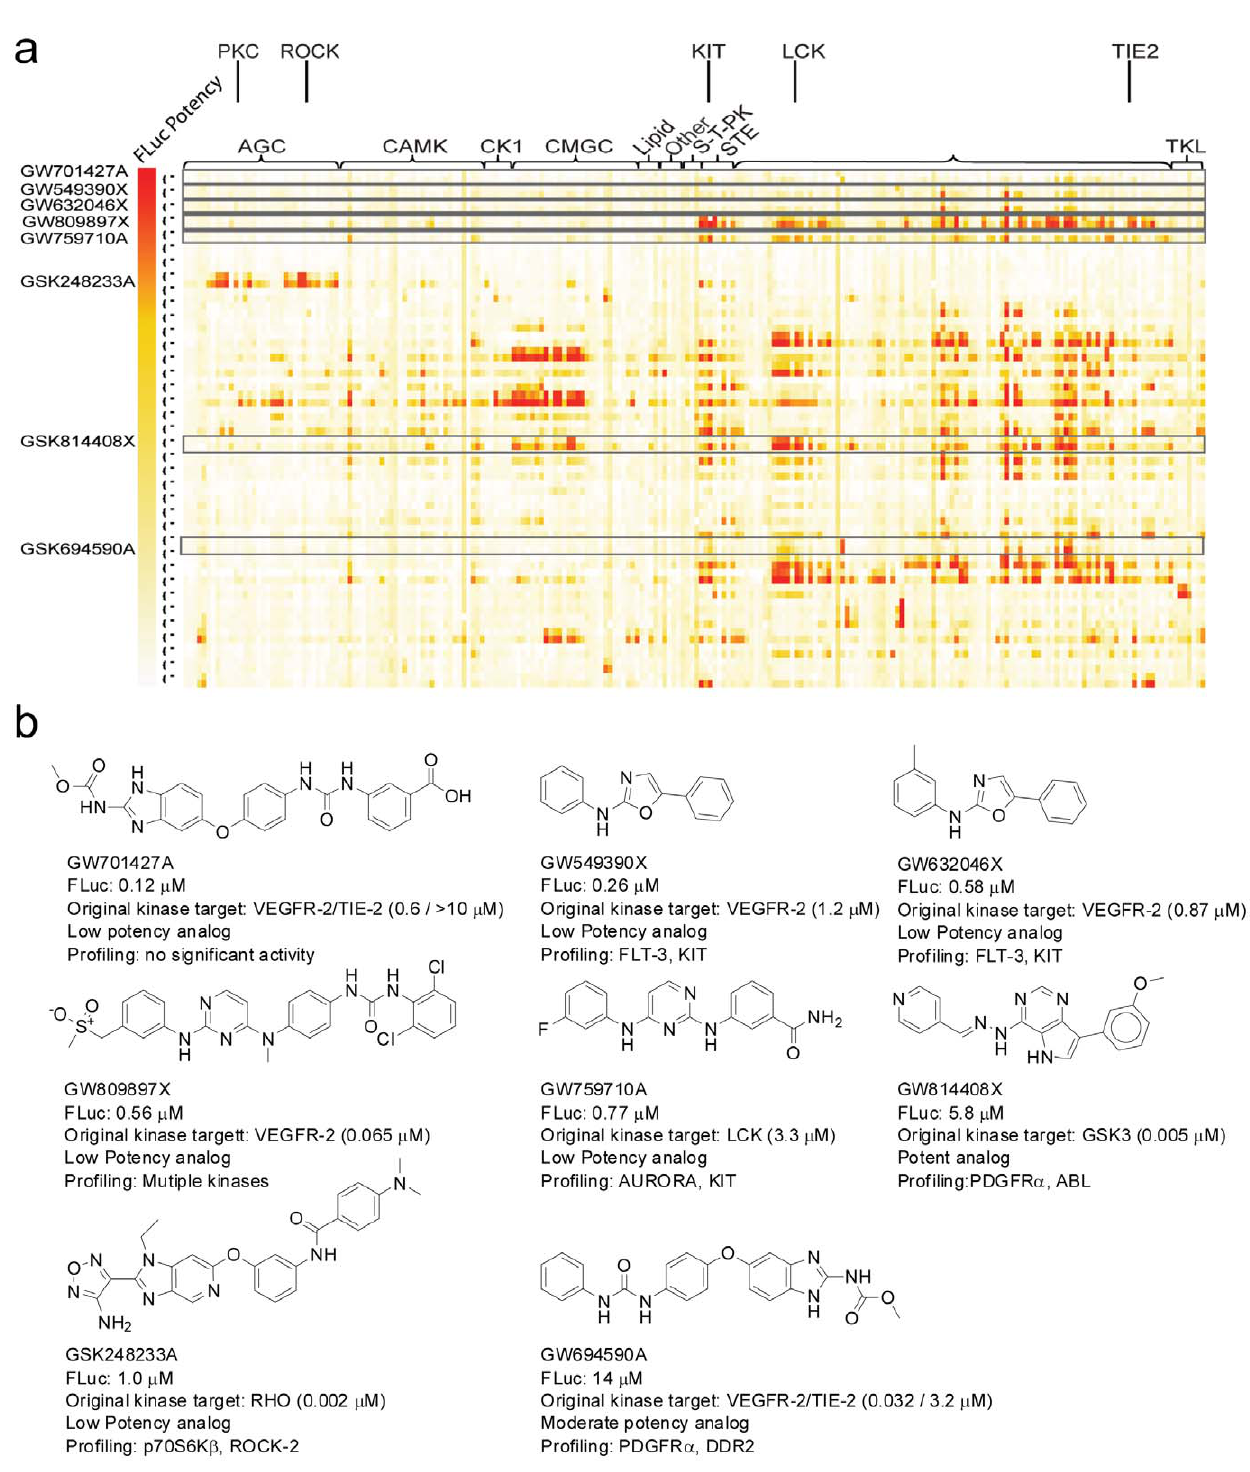
Figure 4. Kinome profiling relating FLuc inhibitory activity vs PKI activity. ( a ) Heatmap depicting the activity of the 367 member GSK PKIS against 224 protein kinases, assayed at two concentrations (0.1 and 1 m M). The vertical heatmap bar depicts the potency of these compounds (IC 50 ) against FLuc. ( b ) Several compounds representative of those displaying FLuc activity between , 1–14 m M IC 50 values are shown and highlighted on the heatmap above. Profiling: kinases showing . 80% inhibition at 100 nM are named.